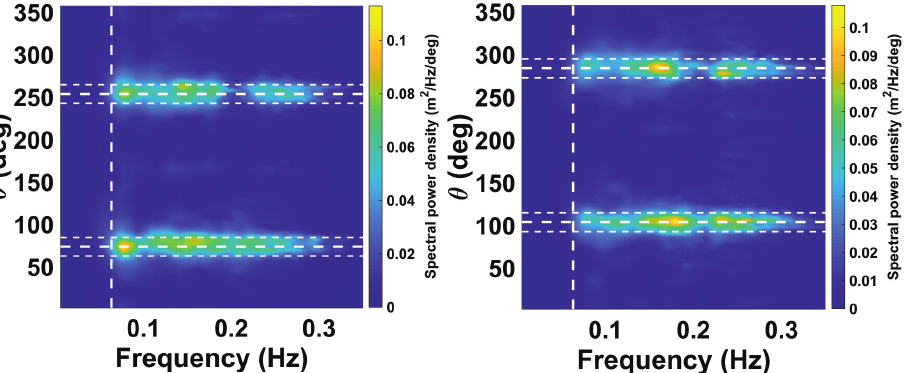
Figure 7. Streaks spectra examples from box 1 (344° N) ( left panel ) and box 2 (14° N) ( right panel ). For the positioning of the corresponding analysis boxes on an actual radar image, please refer to the Figure 4. Both spectra are measured at the calm sea state ( H s ≈ 0.6 m) 27 May 2018 04:02 a.m. (refer to Figure